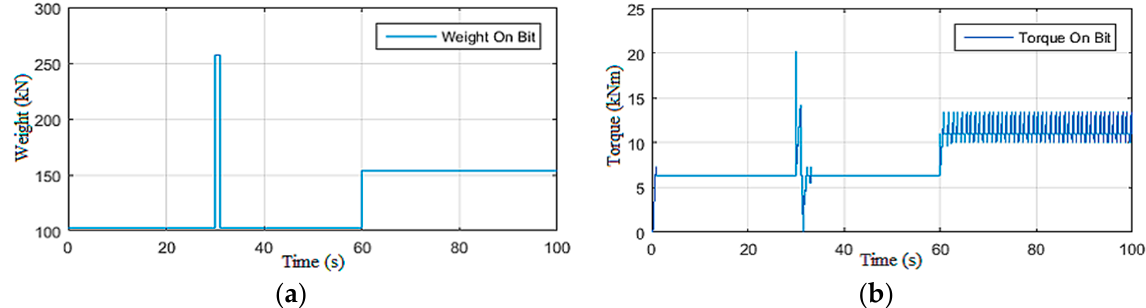
Figure 6. Inputs of Scenario 2: ( a ) weight on bit; ( b ) torque on bit (Tob).